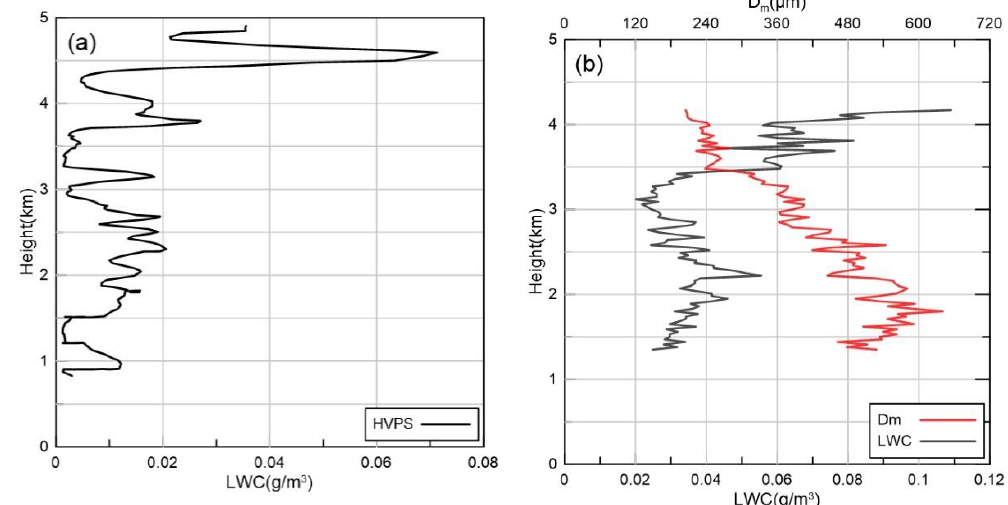
Figure 10. Liquid water content (LWC) observed by high-volume precipitation spectrometer (HVPS) ( a ) and calculated from PSD obtained by MMCR ( b ).